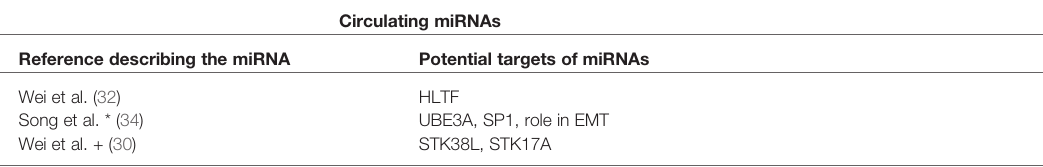
TABLE 2 | Summary of the miRNAs analyzed. miRNA